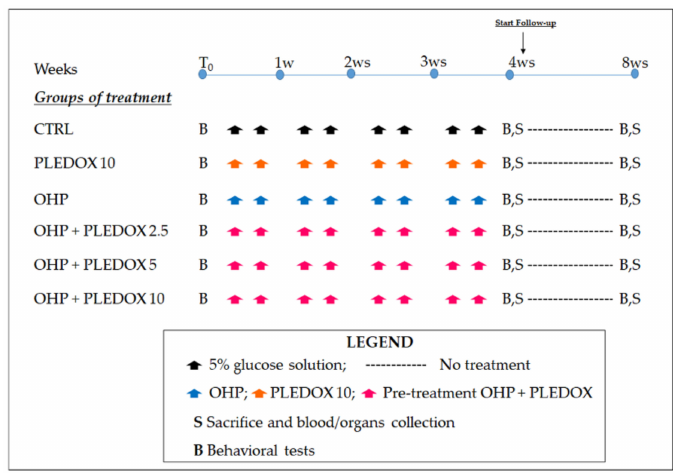
Figure 1. Flow-chart of the study. In the pre-treatment oxaliplatin (OHP) + PLEDOX groups, PLEDOX was administered 10 min before